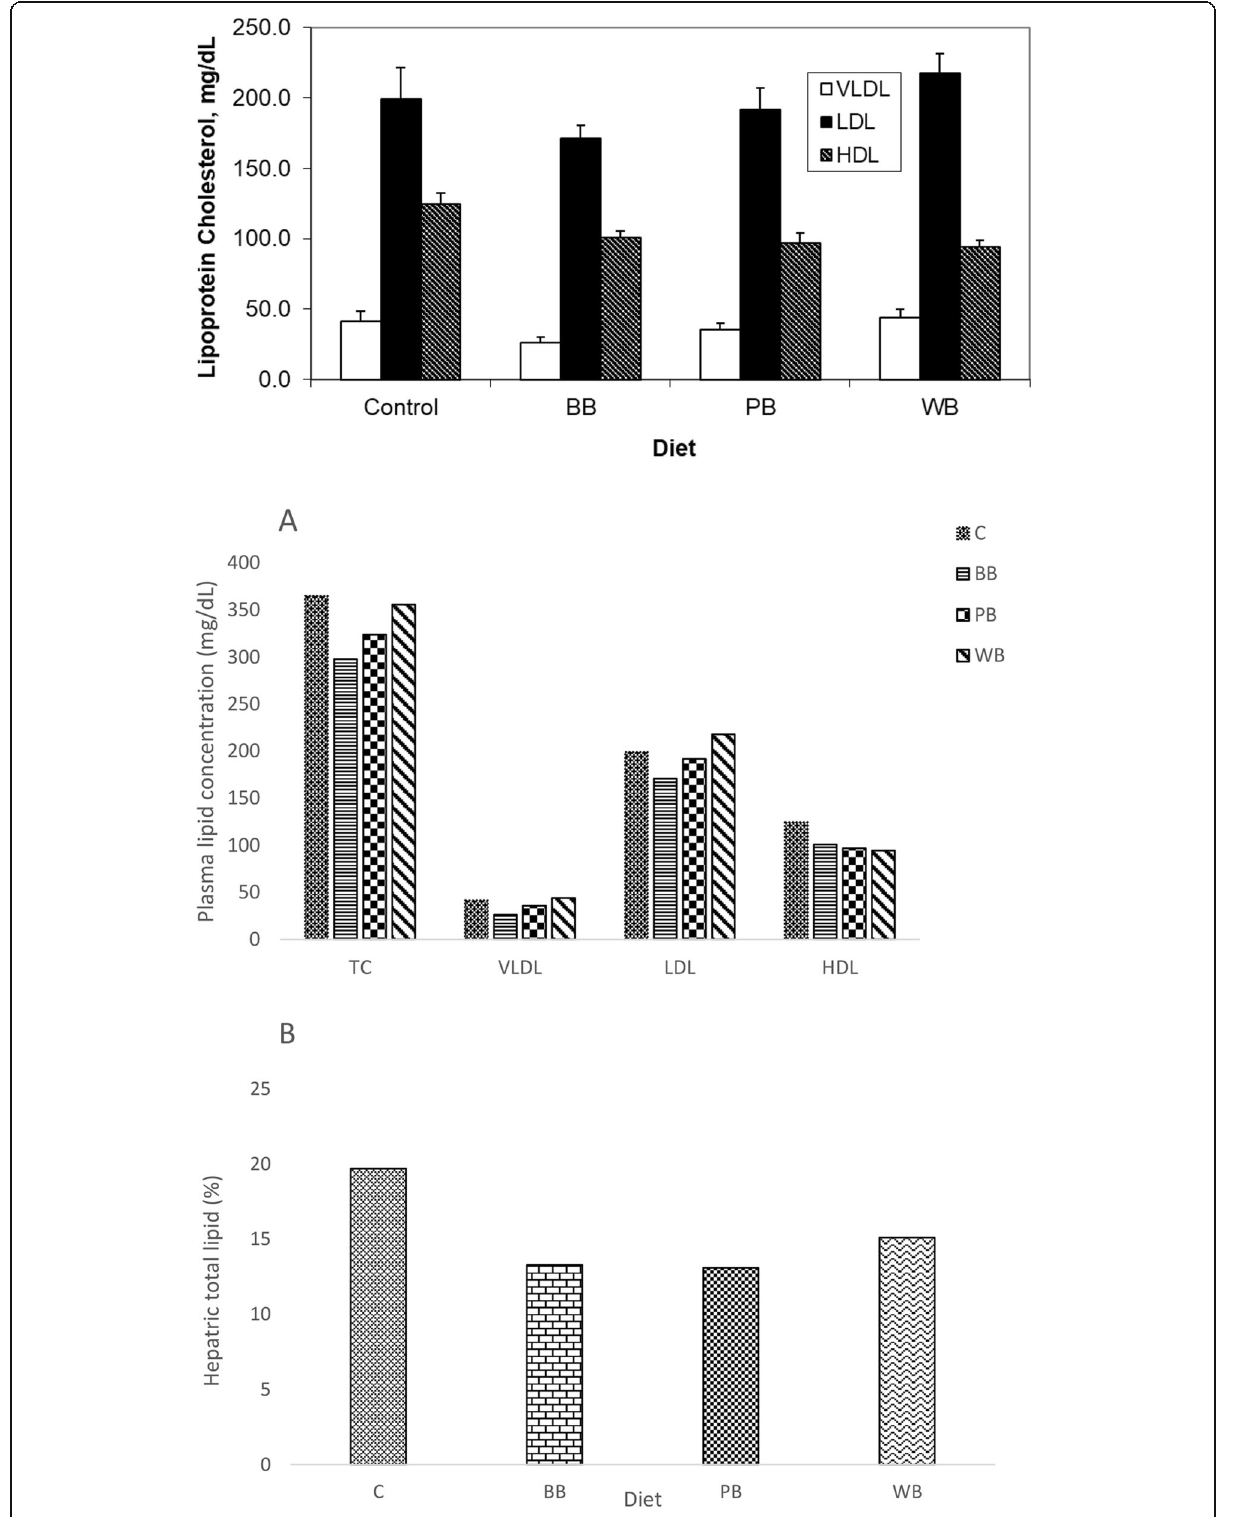
Fig. 1 (See legend on next